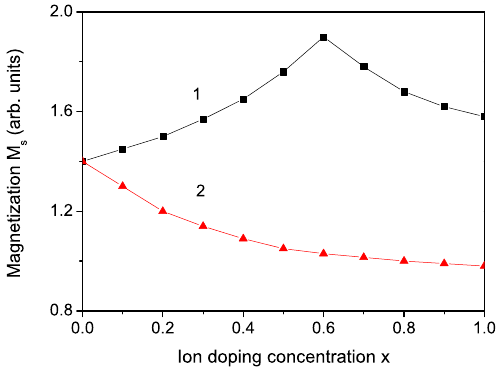
Figure 2. (Color online) Dependence of the magnetization M s on the ion doping concentration x in CCO NP, N = 10, J s 1,2,3 = 1.2 J b 1,2,3 for (1) Co - for 0 ≤ x ≤ 0.6 J d 1 = 1.2 J b 1 for x > 0.6 J d 1 = 0.8 J b 1 ; (2) Pr - J d 3 = 0.8 J b 3 . All other interaction constants in the doped states are assumed to be nearly the same as in the undoped